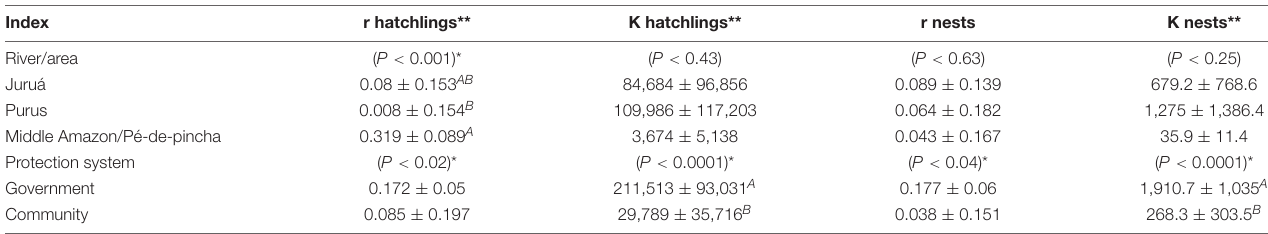
TABLE 1 | Summary of the ANOVA of instantaneous growth rates r and carrying capacity K for number of nests/reproductive females and hatchlings of Podocnemis expansa .